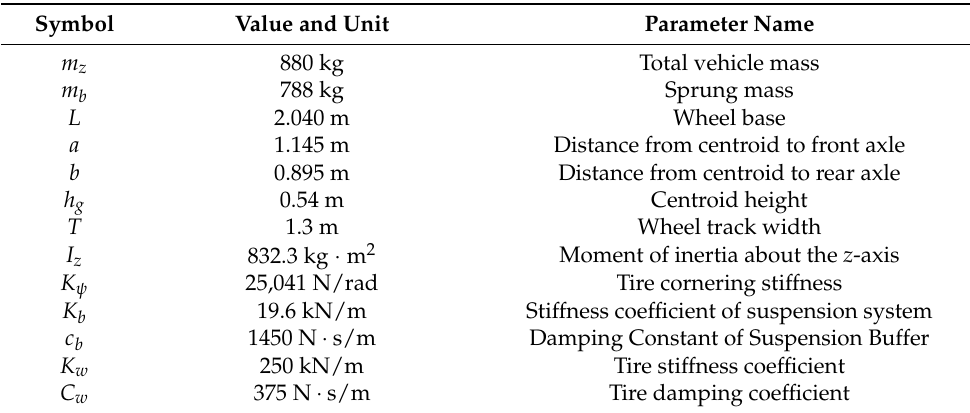
Table 1. Main parameters of